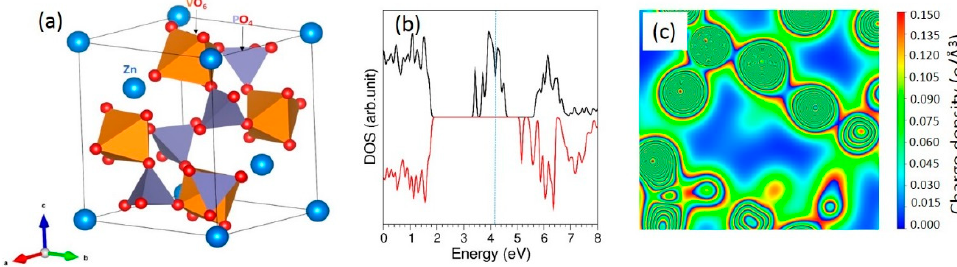
Figure 1. ( a ) Crystal structure of Zn 3 V 4 (PO 4 ) 6 , ( b ) total DOS plot, and ( c ) charge density plot showing the bonding nature in Zn 3 V 4 (PO 4 ) 6 . The vertical blue dotted lines correspond to the Fermi energy level. Table 2. Calculated and experimental parameters of Zn 3 V 4 (PO 4 ) 6 . Calculated Experiment Parameter